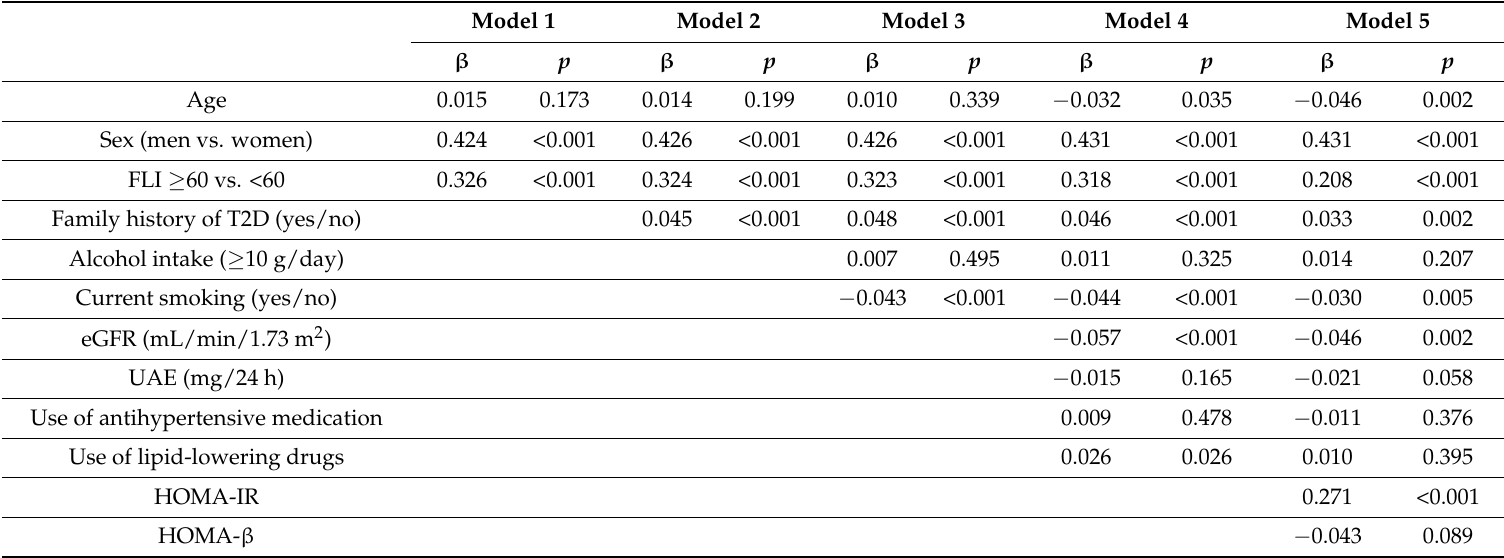
Table 2. Multivariable linear regression analysis demonstrating the positive association of plasma branched-chain amino acids with an elevated fatty liver index (FLI) ( ≥ 60) after adjustment for clinical and laboratory covariates in 5791